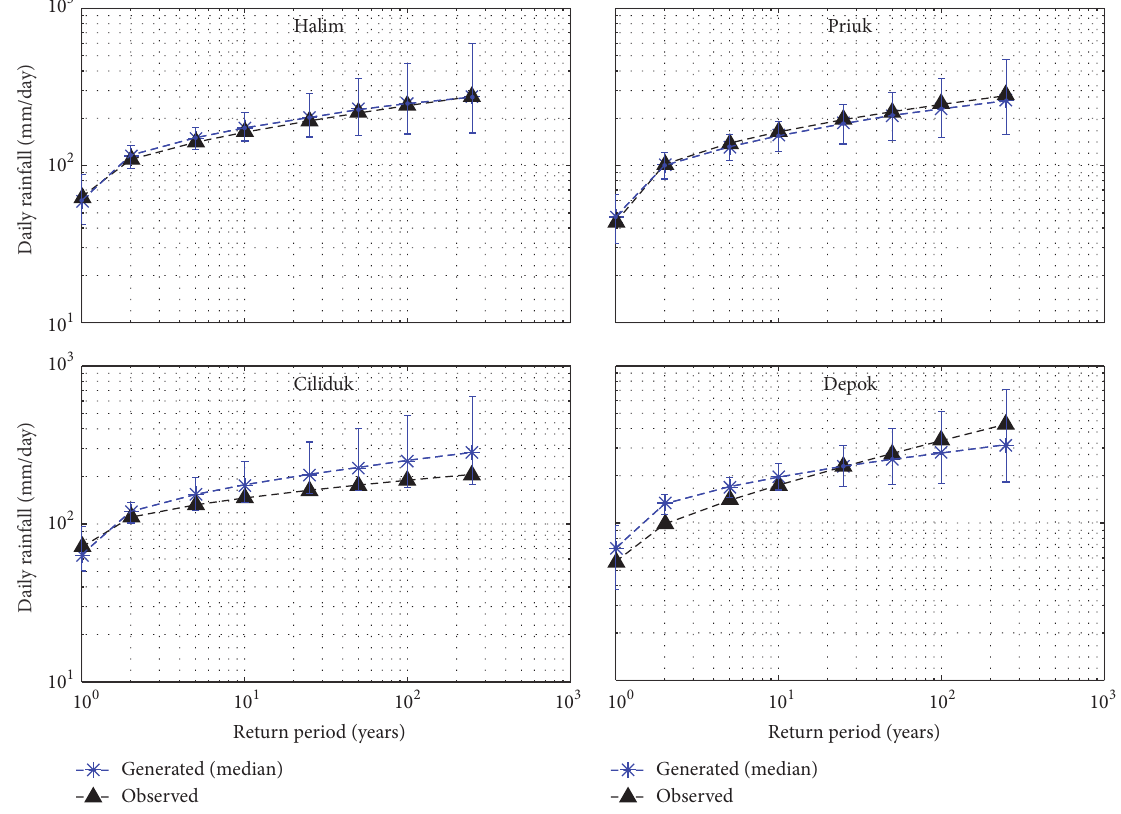
Figure 7: Comparison of RP curves obtained from observations with those from SDSM generated rainfall data. Whiskers indicate minimum and maximum rainfall from 100